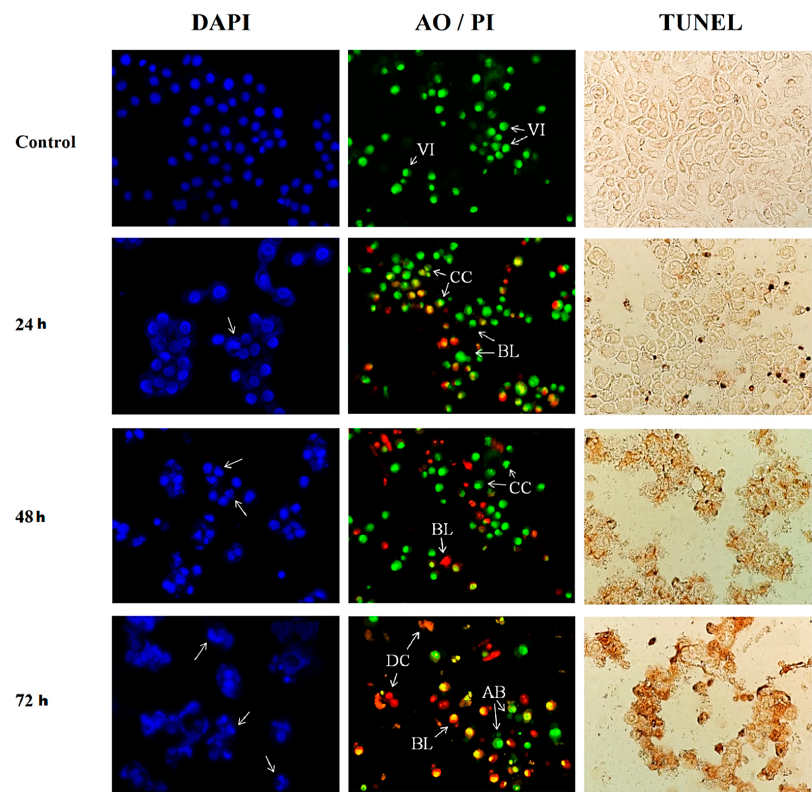
Figure 2. Images of stained HepG2 cells treated with sulforaphene (33.8 µ M) in a time dependent manner. Cells were cultured in serum free RPMI-1640 medium and maintained at 37 ◦ C and 5% CO 2 . DAPI fluorescence images of apoptotic HepG2 cells with arrows indicating chromatin condensation in the cell nucleus; AO/PI fluorescence images of HepG2 cells with arrows indicating viable cells (VI), chromatin condensation (CC), membrane blebbing (BL), apoptotic bodies (AB) and dead cells (DC); TUNEL assay images of HepG2 cells with darkened stains indicating DNA fragmentation within the cells. Magnification × 400;